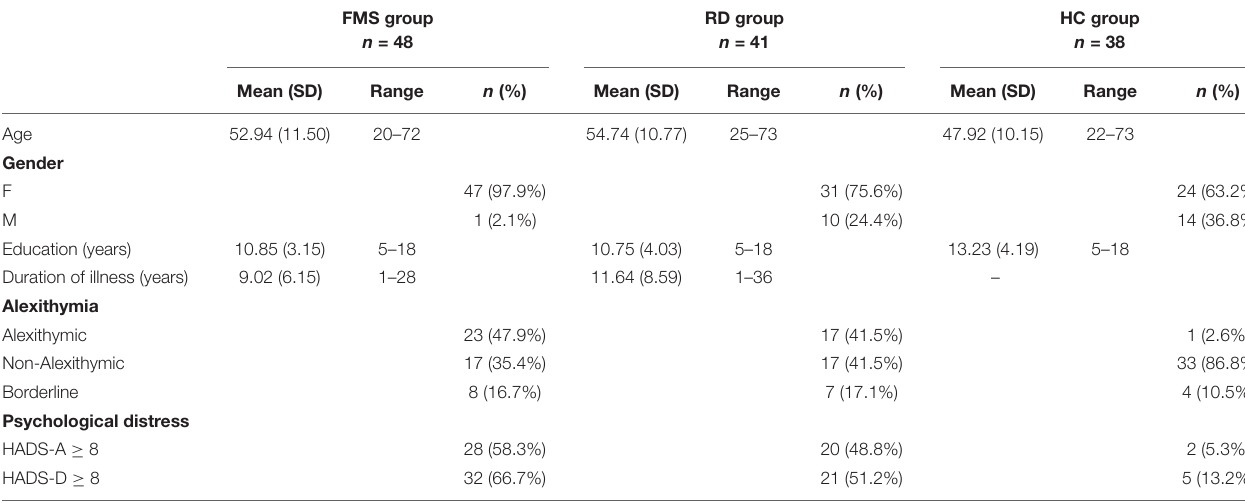
TABLE 1 | Demographic characteristics and prevalence in FMS, RD and HC groups.